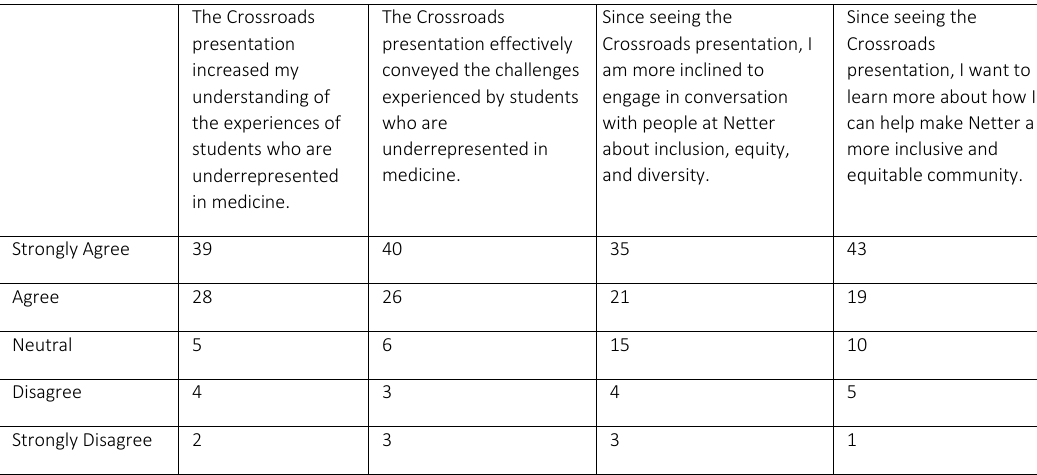
Table 1. Likert-scale survey results after viewing Crossroads video